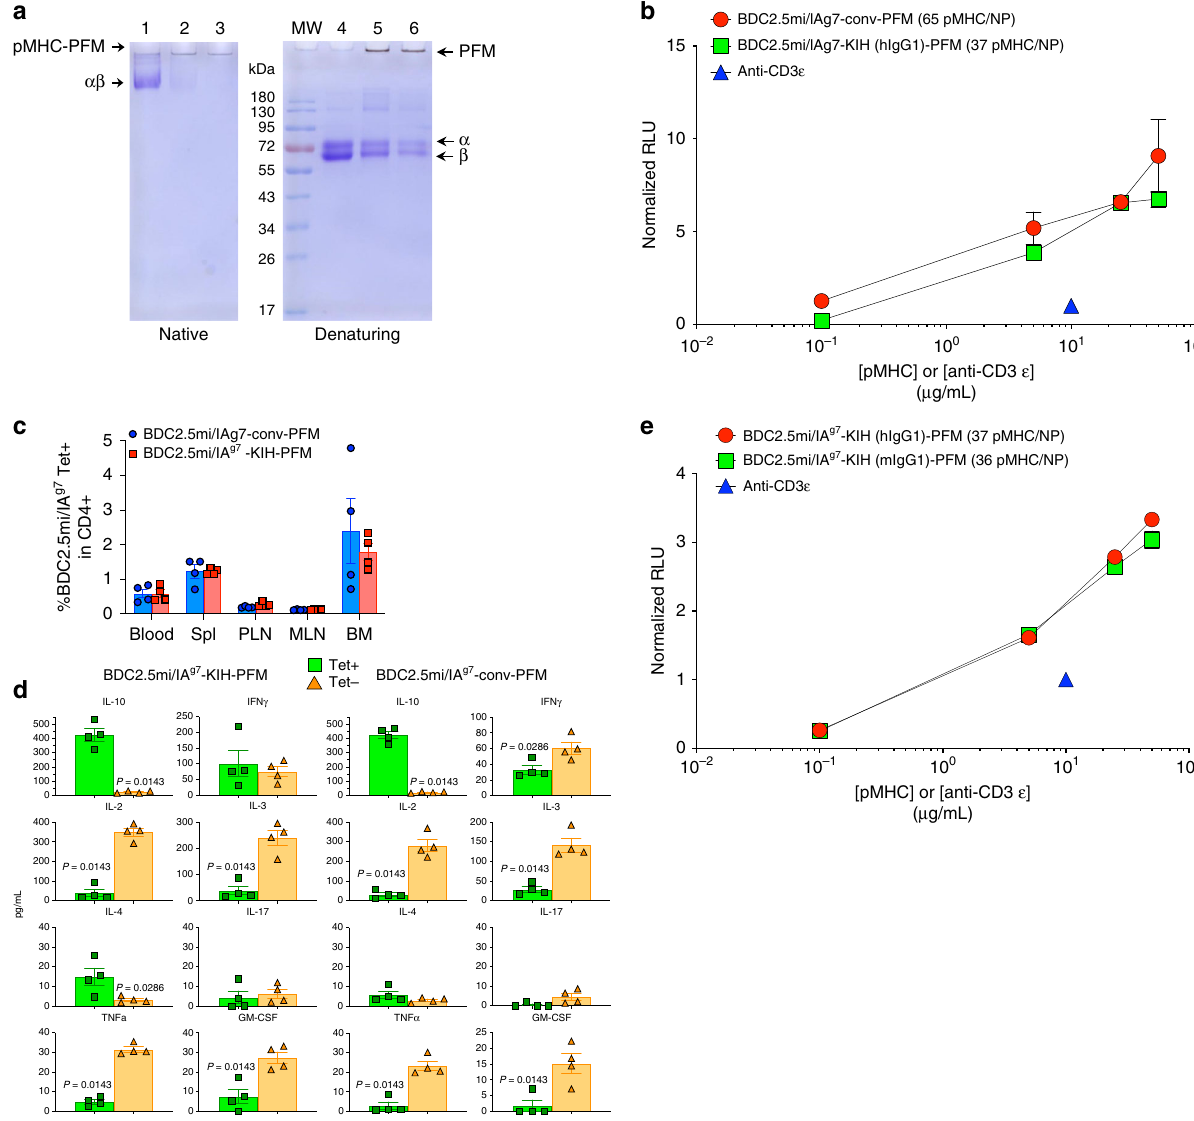
Fig. 7 Biological potency of NPs displaying KIH- vs. c-jun/c-fos-based pMHCII. a Native (left) and denaturing (right) SDS-PAGE for NPs coated with a representative KIH-based pMHCII molecule. PFM denotes the iron oxide NP. MW: molecular weight markers; 1: 2 μ g of KIH-based BDC2.5mi/IA